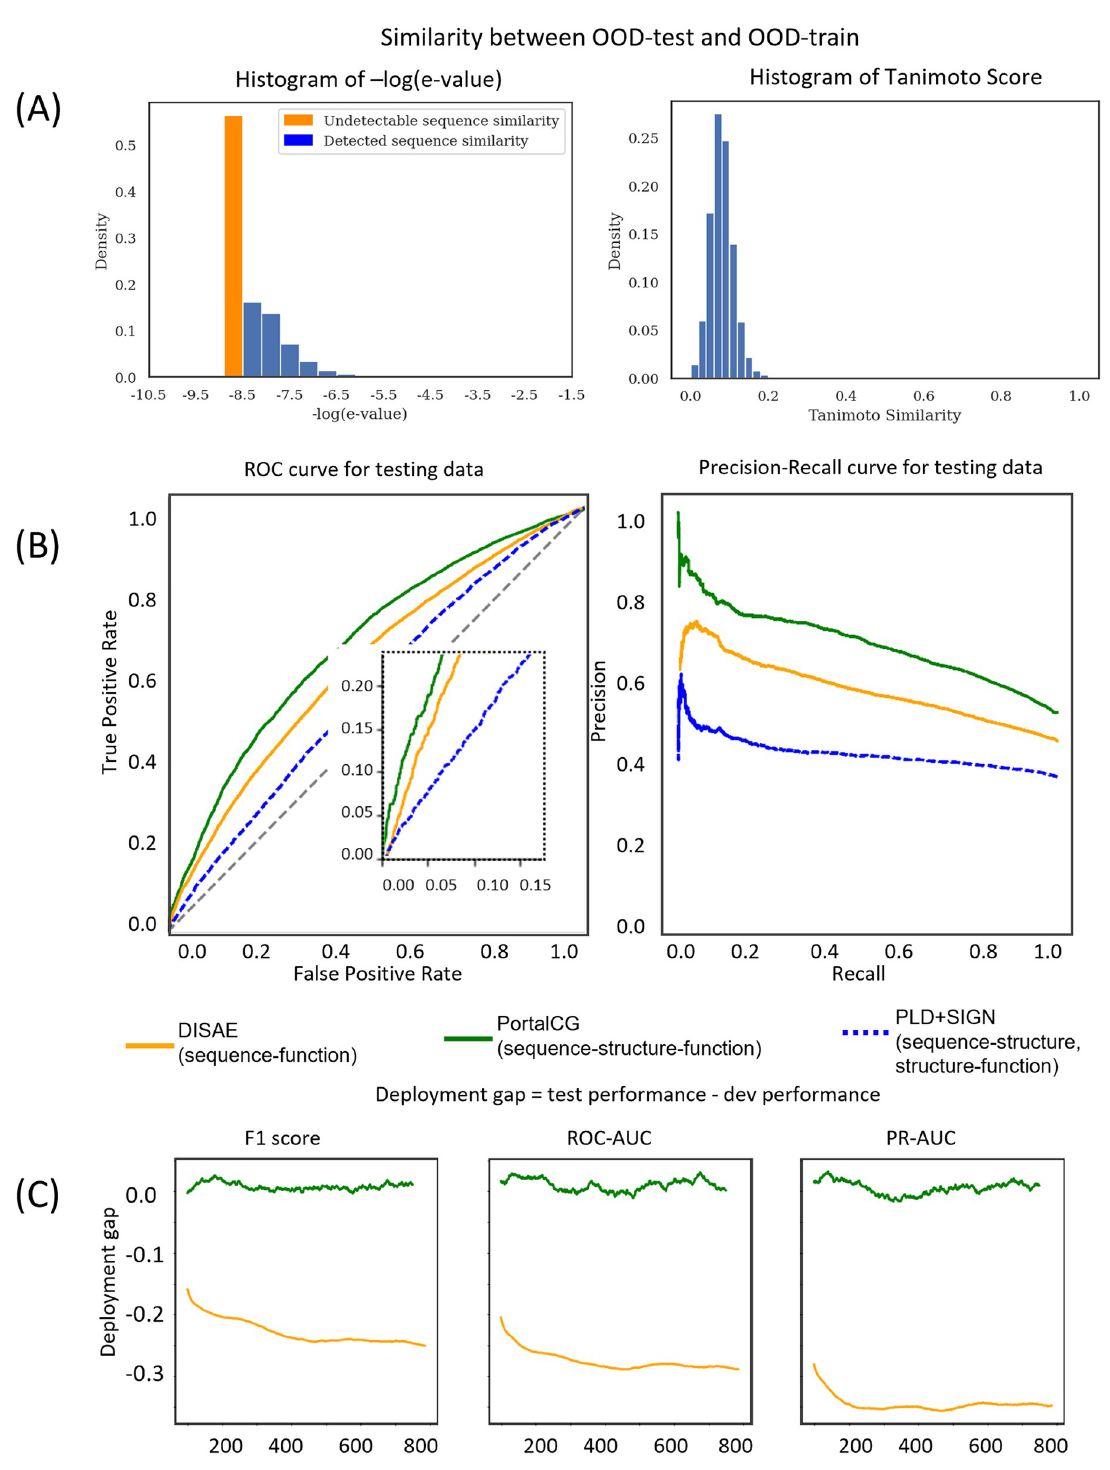
Fig 3. Performance comparison of PortalCG with the state-of-the-art methods DISAE and PLD+SIGN as baselines, using an OOD test with proteins in the test dataset coming from different Pfam families versus proteins in the training and validation datasets. (A) Histograms of protein sequence and chemical structure similarities between OOD-train and OOD-test. The majority of protein sequences in the training set do not have detectable similarity to proteins in the testing set. (B) Receiver Operating Characteristic (ROC) and Precision-Recall (PR) curves for the “best” model instance selected by the stress test. Due to the class-imbalanced active/inactive data, the PR curve is a more reliable measure than the ROC curve. (C) Deployment gaps of PoralCG and DISAE. The deployment gap of PortalCG is steadily around zero as the number of training steps increases, while the deployment performance of DISAE deteriorates. https://doi.org/10.1371/journal.pcbi.1010851.g003 PLOS Computational Biology | https://doi.org/10.1371/journal.pcbi.1010851 January18,